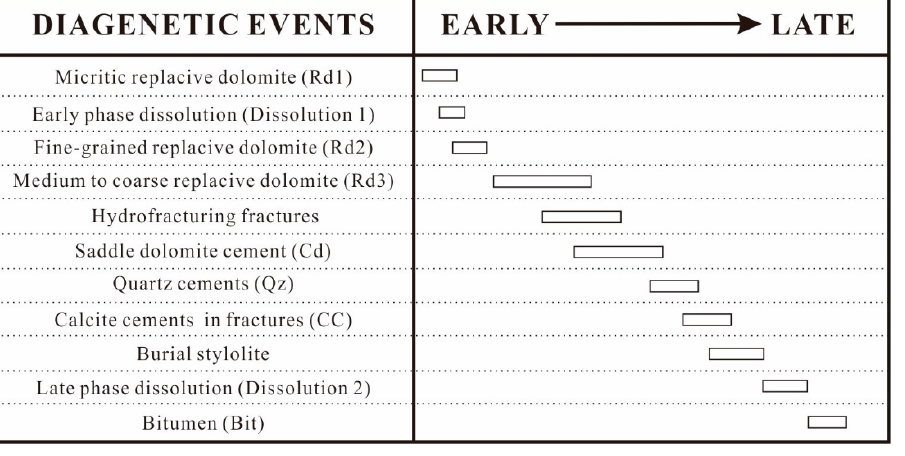
Figure 18. The diagenetic sequence of Middle Permian in SW Sichuan Basin.